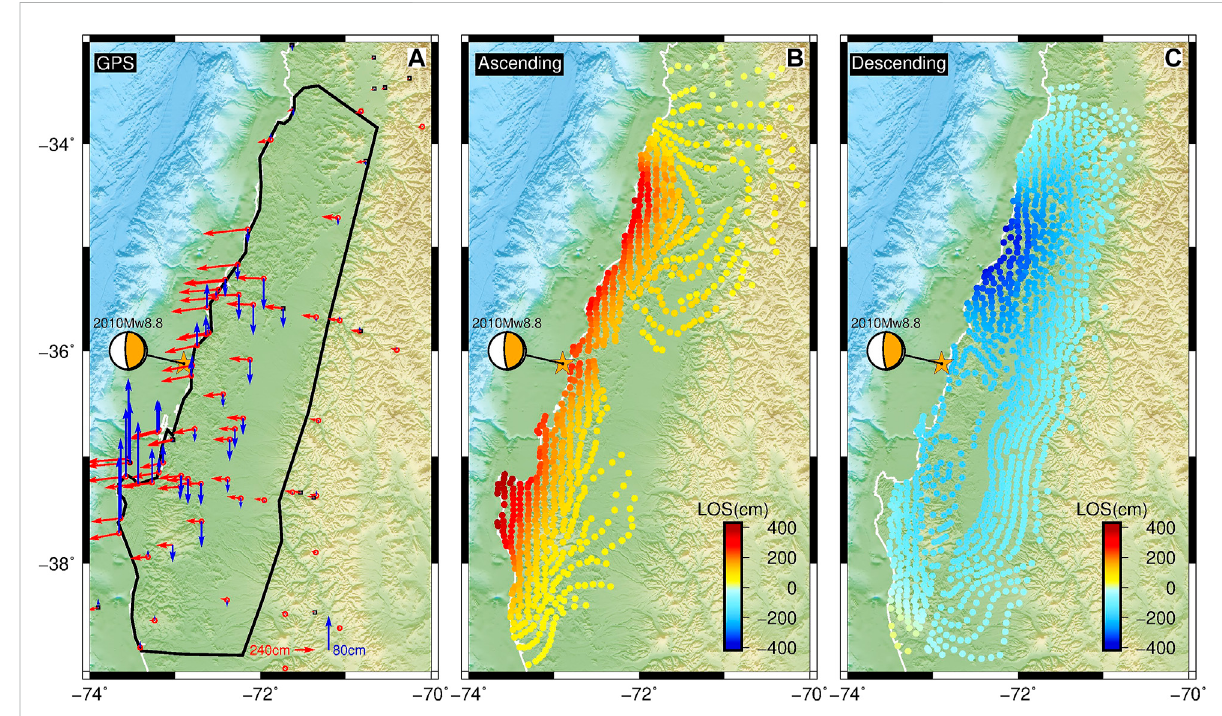
The distribution of the data set used in this study. (A) The GPS data; the black line denotes the area of three-dimensional displacement to be estimated. (B) The ascending ALOS LOS displacements. (C) The descending ALOS LOS